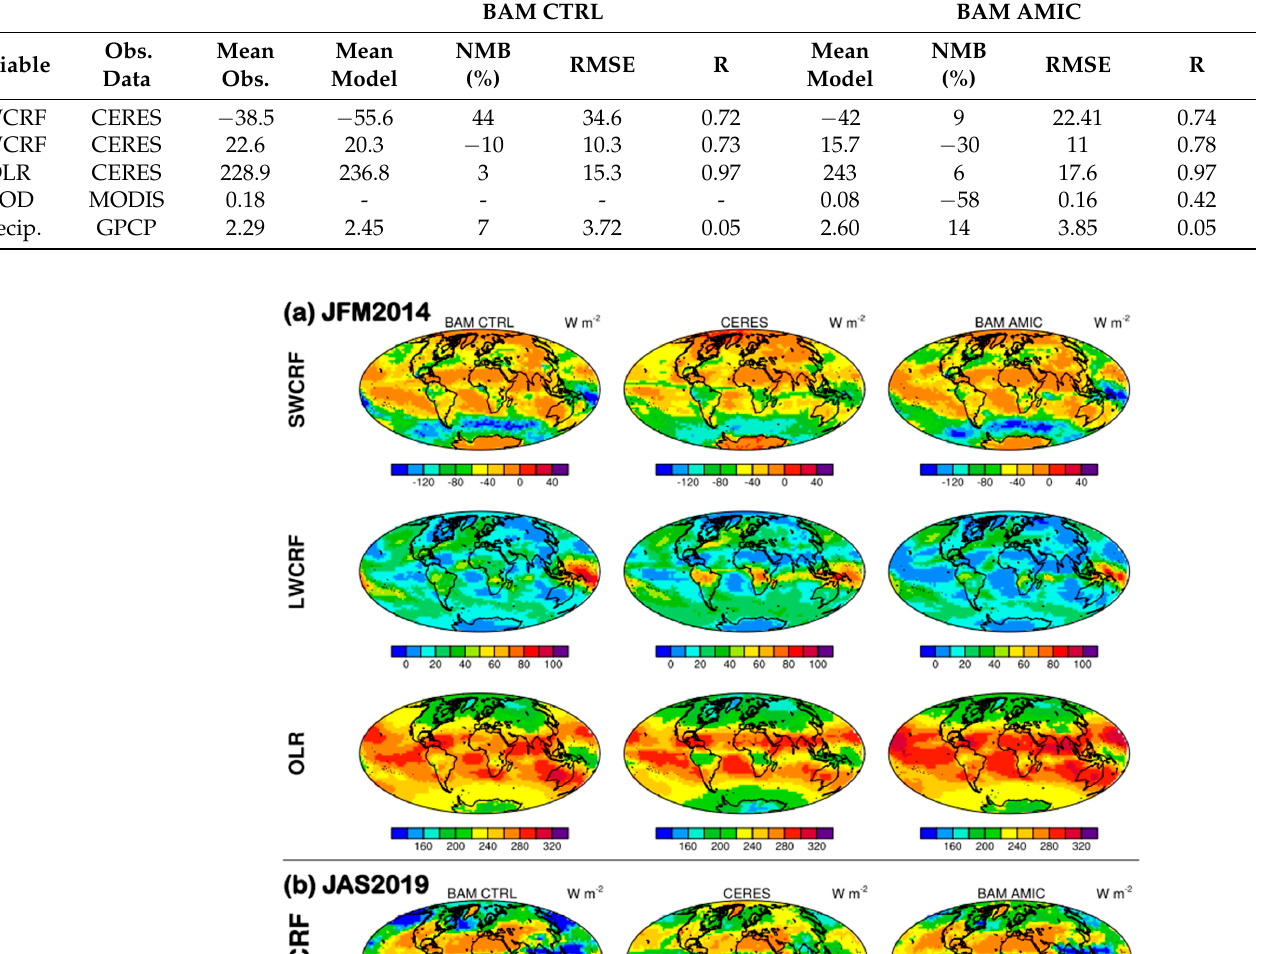
Table 4. Model performance statistics of cloud properties and precipitation for JAS2019 set of experiments. BAM CTRL BAM AMIC